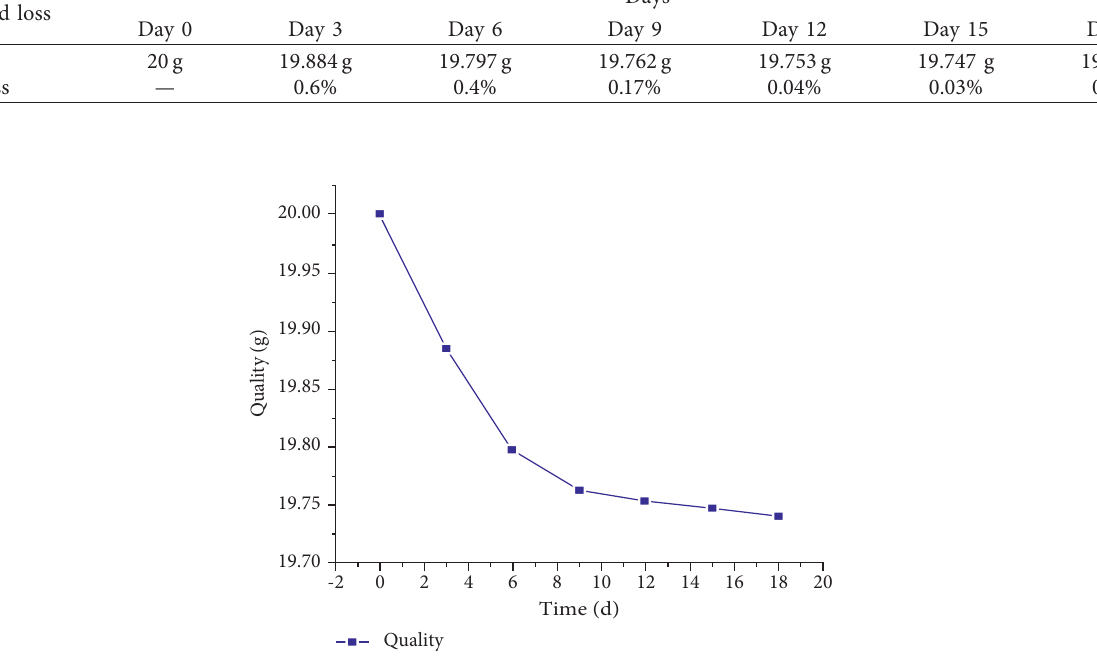
Figure 13: The mass trend of the microbial